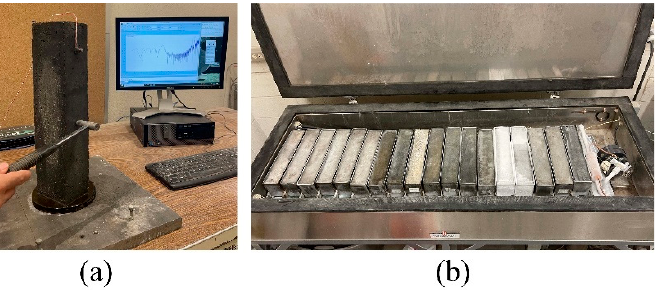
Figure 3. Freezing and thawing test: ( a ) fundamental frequency test and ( b ) freeze-thaw chamber.